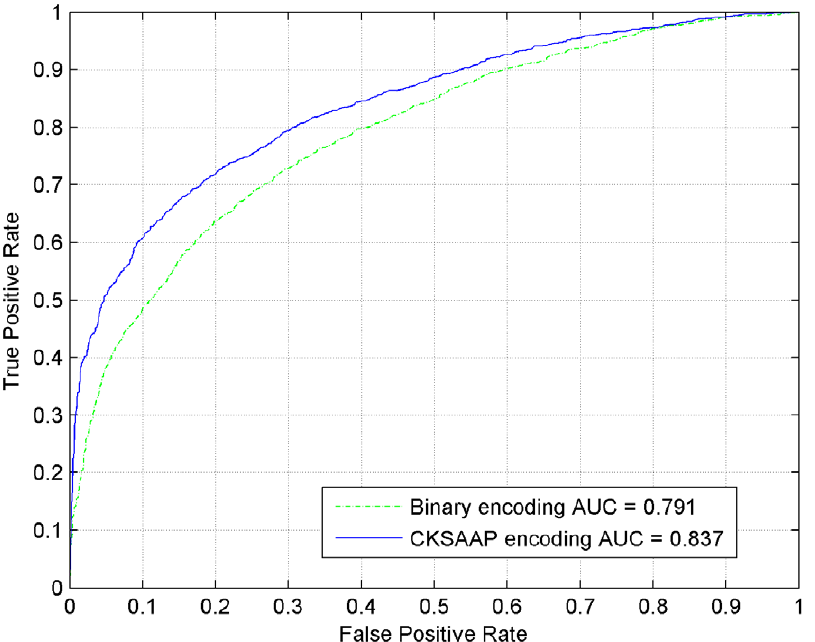
Figure 3. ROC curves of CKSAAP_PhSite and the binary encoding scheme in terms of tyrosine (Y) site prediction based on the training dataset.